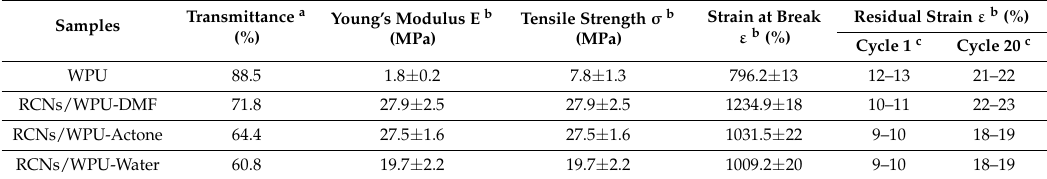
Table 3. Characterization Data for WPU and RCNs/WPU